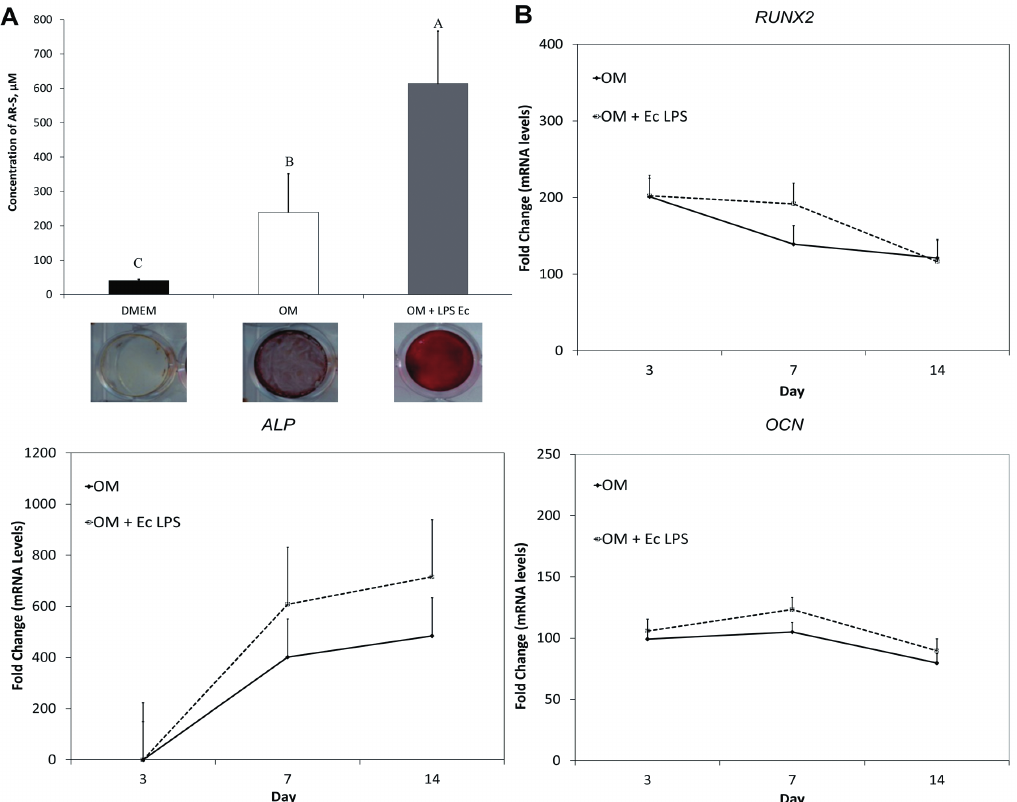
Figure 4- Osteoblast differentiation of PDL-CD105 + cells under EcLPS exposure. (A) Quantification of Alizarin Red staining showed that EcLPS at concentration of 1 μg/ml increased mineral nodule formation at 21 d. (B) PDL-CD105 + cells were cultured in osteogenic medium (OM) alone or in OM+EcLPS (1 μg/ml). Data are presented as fold increase relative to non-induced controls for quantitative real-time PCR analysis showing that EcLPS did not alter the expression pattern of mRNAs for RUNX2, ALP, and OCN. All genes tested were normalized to the corresponding housekeeping gene, GAPDH. Representative data of three independent experiments are presented. Bars in (A) represent mean±standard deviation (SD) where intergroup statistical differences analysis are indicated by different capital letters